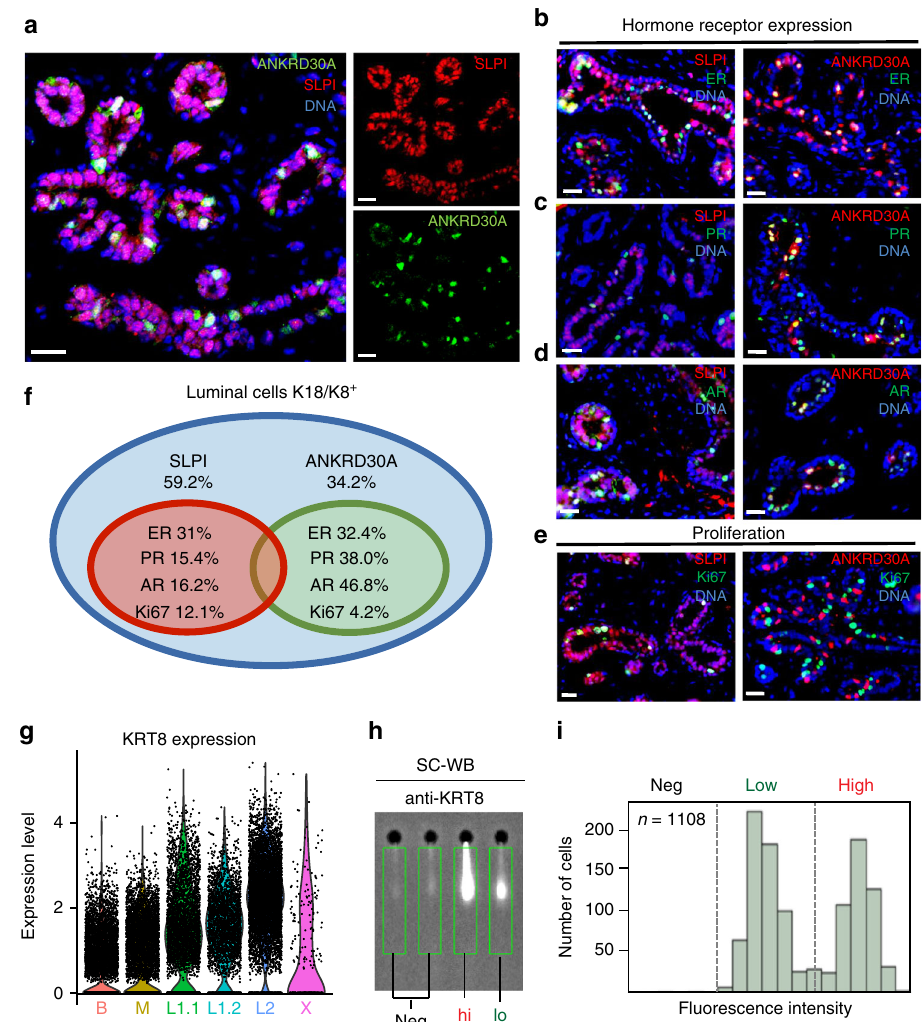
Fig. 5 Validation and spatial integration of two distinct luminal cell types. a Immuno fl uorescence analysis of NY-BR-1 protein expression (green) in combination with basal marker SLPI (red) and DNA stain using DAPI (blue) within tissue sections from primary human reduction mammoplasty samples revealed that NY-BR-1 and SLPI are markers for distinct luminal subpopulations. b – e Immuno fl uorescence analysis of NY-BR-1 and SLPI (red) protein expression with: hormone receptors for estrogen receptor ( b ), progesterone ( c ), and androgen ( d ) and proliferation marker Ki67 e in green. f Summary of hormone receptor and proliferation marker expression in L1 and L2 cells. g Violin plot showing expression of KRT8 in the luminal subpopulations, higher expression is seen in the luminal L1.1 and L1.2 subpopulation. h Sample frame for detection of KRT8 protein content from individual cells using single cell Western blot following detection using microarray scanner. i Population summary showing cell number per fl uorescence intensity con fi rmed bimodal distribution of KRT8 expression on the protein level. See Supplementary Fig. 5 for violin plots displaying expression of relevant hormone receptors as well as proliferation and luminal progenitor markers. All scale bars = 25 µ